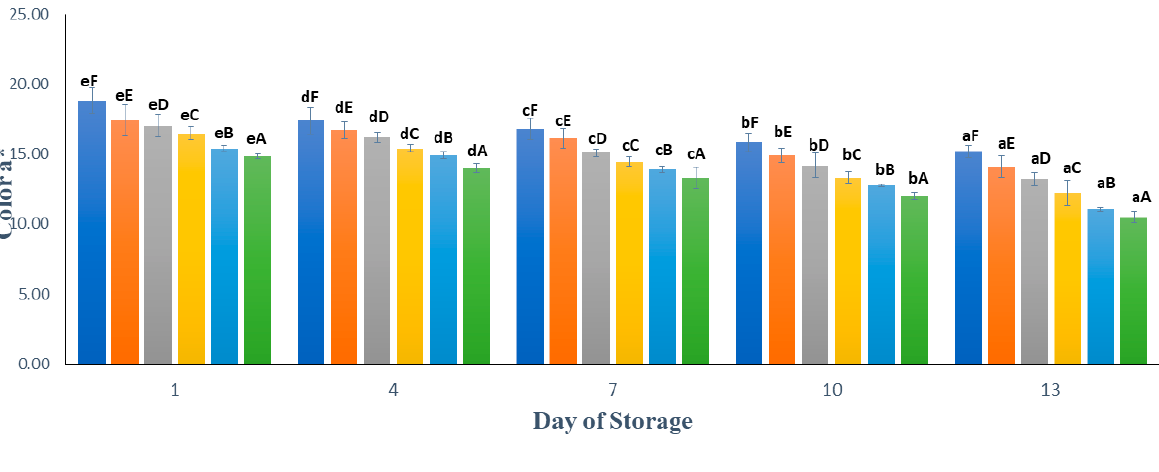
Figure 5. Effect of edible coating of gelatin composite enriched with black tea extract on the color (a*) of cut watermelon during storage. The value shown is the average of the three experimental replications. A–F Values followed by the same capital letters showed no significant difference ( p > 0.05) between treatments on the same day. a–e Values followed by the same non-capital letters showed no significant difference ( p > 0.05) between storage times in the same treatment.